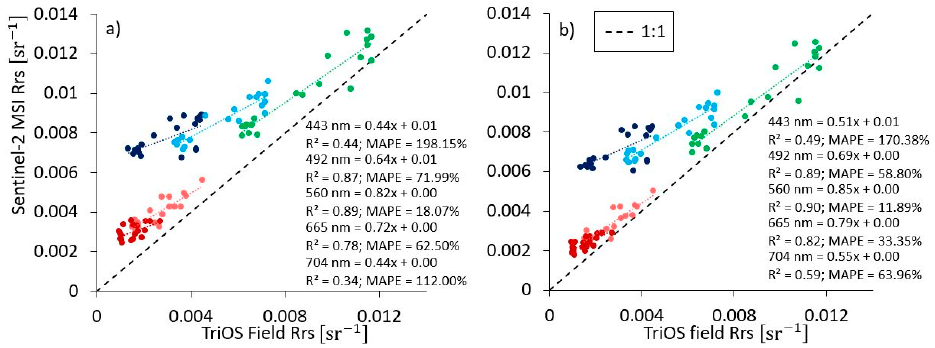
Figure 12. Comparison between Field R rs ( λ ) and MSI R rs ( λ ) for B1 to B5: ( a ) without glint removal; and, ( b ) with glint removal.